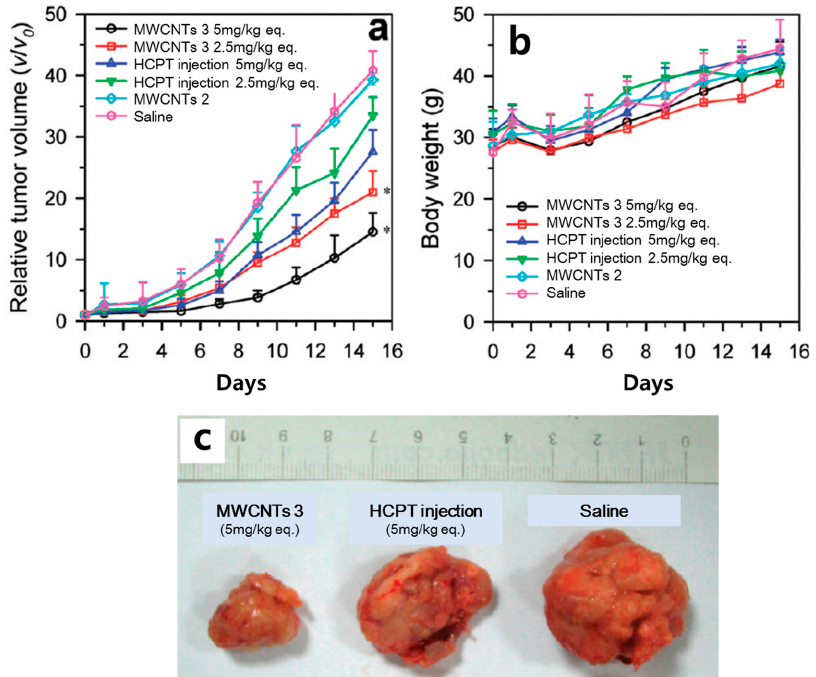
Figure 2. ( a ) In vivo antitumor effect obtained from treatment with multi-walled carbon nanotubes (MWCNTs), 10-hydroxycamptothecin (HCPT), and saline (control) in a mouse model, expressed as the average values of the relative tumor volume v / v 0 (where v denotes the tumor volume at test time points and v 0 denotes the corresponding initial tumor volume at the beginning of treatment). * p < 0.05 (versus the HCPT injection group at the equivalent dose from the 5th day). ( b ) Change in body weight of each group during the experiments. Data in ( a , b ) are presented as mean ± SD ( n = 8); ( c ) Typical photographs of excised sarcomas from mice on the 16th day after treatments with MWCNTs 3 (5 mg/kg equiv.), HCPT injection (5 mg/kg equiv.), and saline. Reprinted with permission from Ref. [14]. Copyright (2016) American Chemical Society.